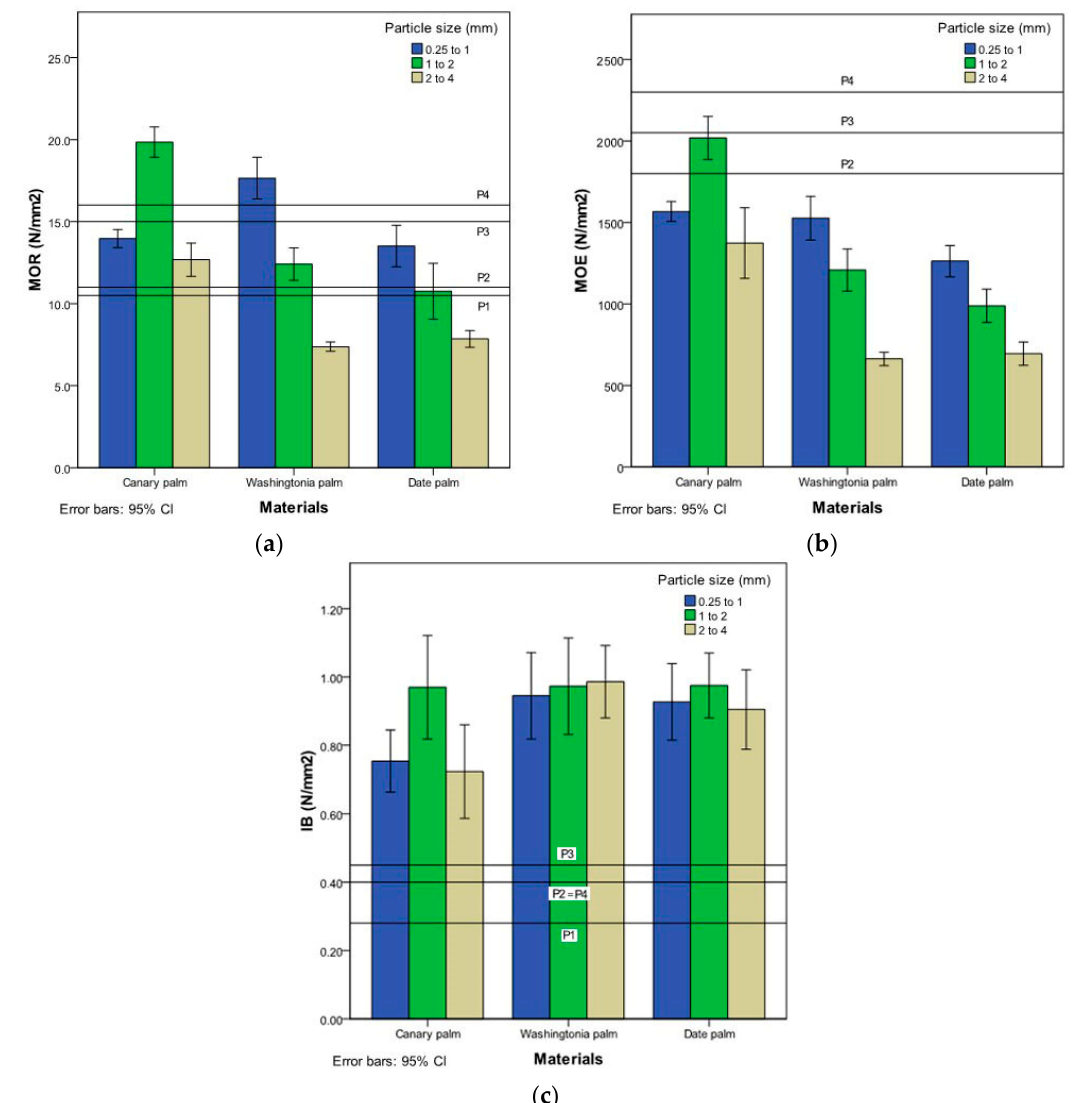
Figure 6. ( a ) MOR. ( b ) MOE ( c ) IB according to palm species and particle size and compared to the European standards (black horizontal lines) [46].